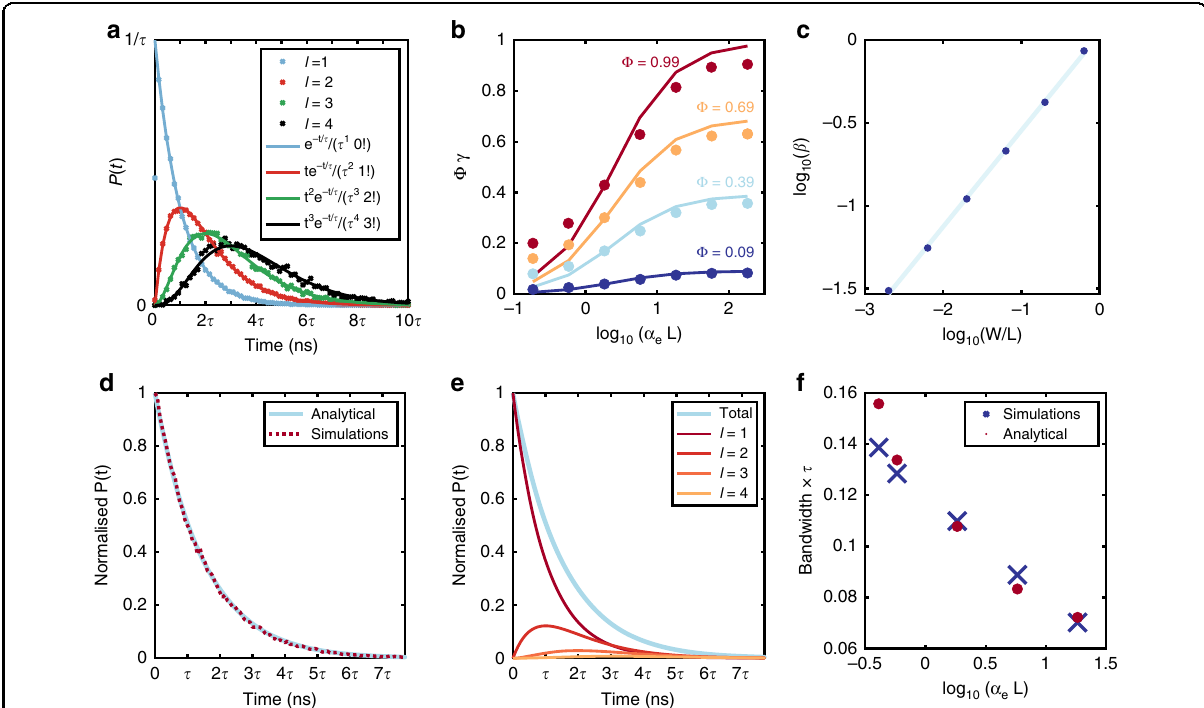
Fig. 3 Analytical solution to impulse response prediction. a Comparison between normalised time curve contributions from simulations (solid line) grouped by the number of fl uorescence events, l , compared to the analytical solution of probability density functions for l = 1 (blue), 2 (red), 3 (green), and 4 (black) as a function of time in multiples of τ . b Simulated (points) and fi tted (solid lines) for Φ γ plotted against the logarithm of α e L for a range of quantum yields: (from top to bottom) QY, Φ = 0.99, 0.69, 0.39, and 0.09. c Dependence of fi tting constant β as a function of the ratio of device width to length. d Comparison between simulated (dashed) and analytical (solid) solutions for the impulse response of an example LSC as a function of time. e Deconstruction of the analytical impulse response from d into the contributions from photons that have undergone l absorption events for l = 1, 2, 3, and 4. f Comparison of normalised bandwidths for simulated (blue crosses) and analytically predicted (red circles) for a series of LSCs with varied fl uorophore